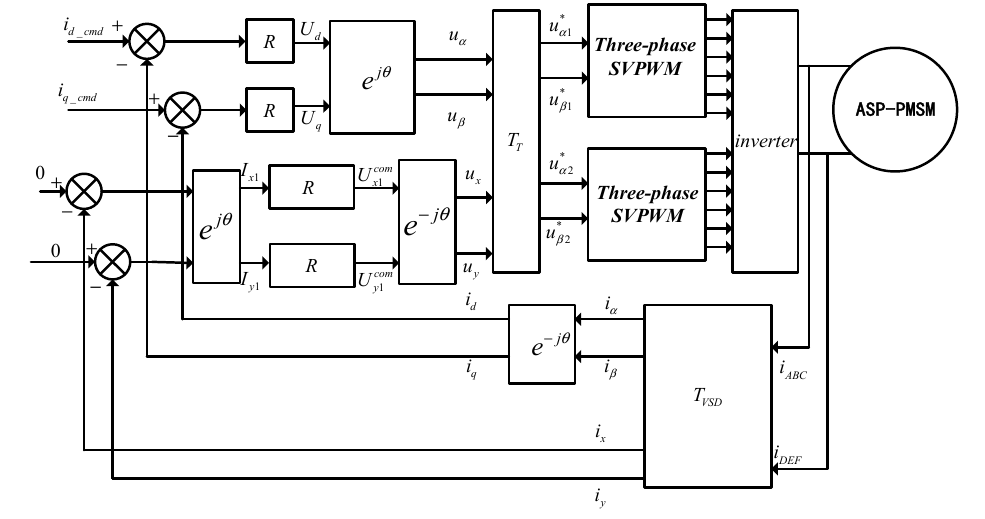
Figure 9. Control diagram of a control scheme for ASP-PMSM.